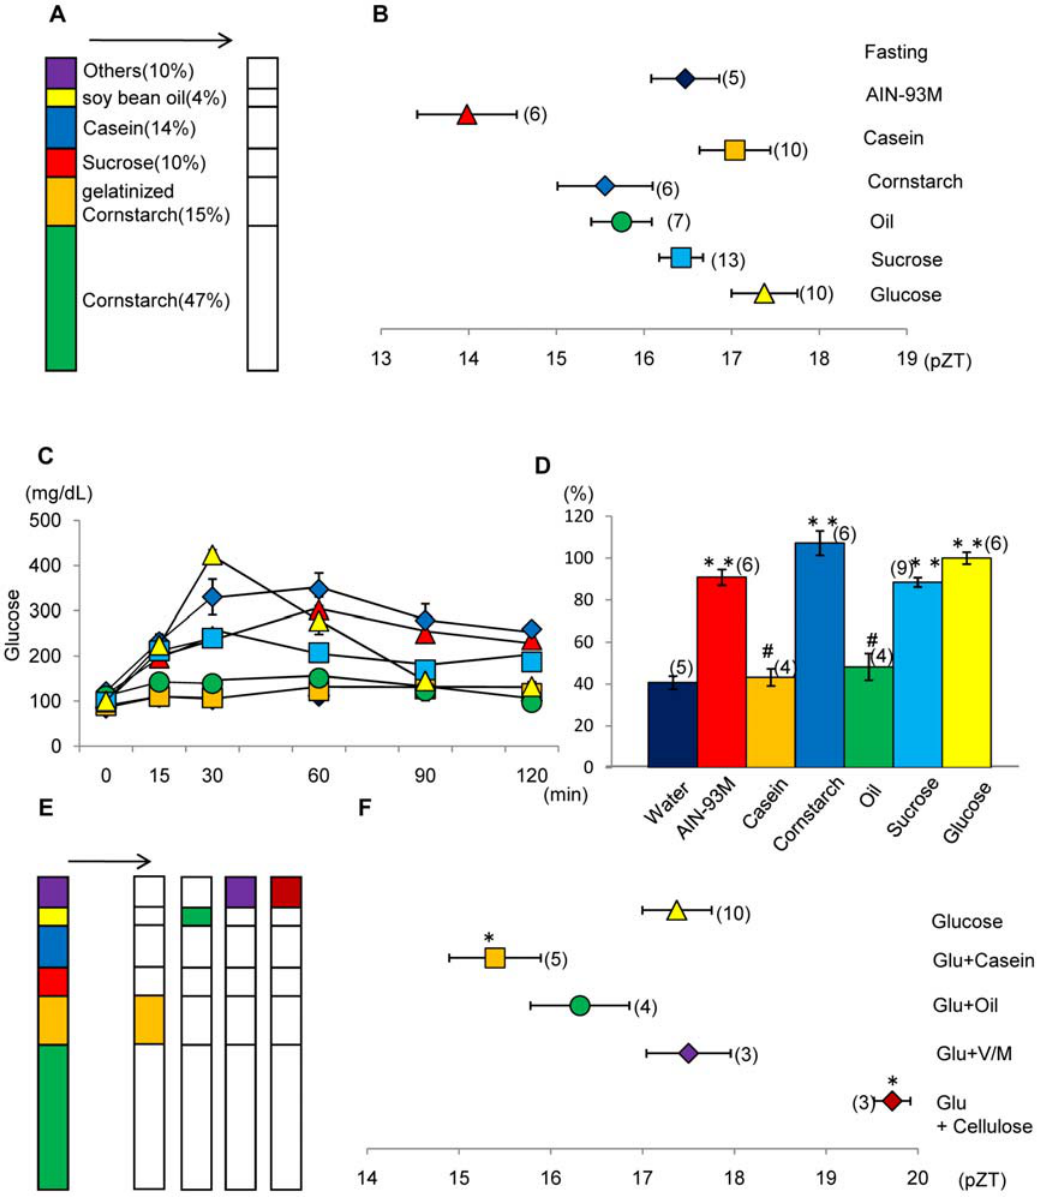
Figure 2. Effects of complete substitution by single nutrient components in the AIN-93M diet on the phase of the liver circadian clock and relative blood glucose value. A: Percent component of each nutrient in AIN-93M. Other contents were 3.5% AIN-93 mineral mixture, 1% AIN-93 vitamin mixture, 0.25% choline bitartrate, and 0.0008% tert-butyl hydroquinone. Substituted components are shown by the white column segments. B: Mice were administered a diet tablet containing 0.6 g/10 g BW of each nutrient on the first day and 0.85 g/10 g BW of each nutrient on the second day after 24-h food deprivation. Some mice were administered 0.3 mL of soybean oil on the first day and 0.43 mL of soybean oil on the second day after 24-h food deprivation. The values indicate the mean 6 SEM. The horizontal axis indicates the pZT at the peak of the bioluminescence rhythm. Fisher’s PLSD test. * P , 0.05 (vs. fasting); fasting, 2-day fast # P , 0.05, ## P , 0.01 (vs. AIN-93M). C: Time course of the blood glucose level after oral injection of 0.03 g/10 g BW of AIN-93M, 100% cornstarch, 100% casein, 100% sucrose, or 100% glucose or 0.015 mL/10 g BW of 100% soybean oil. For the control, 0.33 mL/10 g BW of water was administered. The vertical axis indicates the content of glucose (mg/dL). Symbol color of each treatment is same as column color in part D. D: Relative blood glucose value (% of blood glucose level produced by 100% glucose) of each nutrient group. This value was calculated by the following formula: 100 6 [AUC (area under the blood glucose concentration-time curve) during 2 h after each nutrient administration/AUC during 2 h after 100% glucose administration]. The values indicate the mean 6 SEM. Fisher’s PLSD test. ** P , 0.01 (vs. water). # P , 0.05 (vs. AIN-93M). The numbers in the parentheses indicate the number of tested mice. E: Percent component of each nutrient in AIN-93M. Substituted components are shown by the white column. F: Effect of combination of 100% glucose, 86% glucose + 14% casein, 96% glucose + 4% soybean oil, 95% glucose + 5% cellulose, or 95.5% glucose + 3.5% AIN-93 mineral mixture and 1% AIN-93 vitamin mixture on the liver circadian clock. Feeding schedule was the same as in Fig. 2B. The values indicate the mean 6 SEM. The horizontal axis indicates the pZT at the peak of the bioluminescence rhythm. Fisher’s PLSD test. * P , 0.05 (vs. 100% glucose). # P , 0.05 (vs. AIN-93M). The numbers in parentheses indicate the number of tested mice. We used the same data of fasting and AIN-93M as mentioned in Fig. 1 to produce Fig. 2.